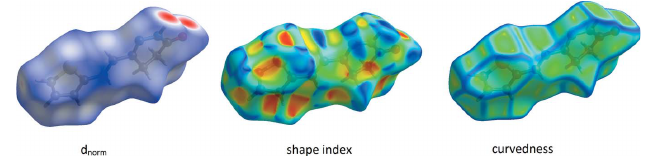
Figure 3 The Hirshfeld surfaces of the title compound mapped over d norm , shape- index and